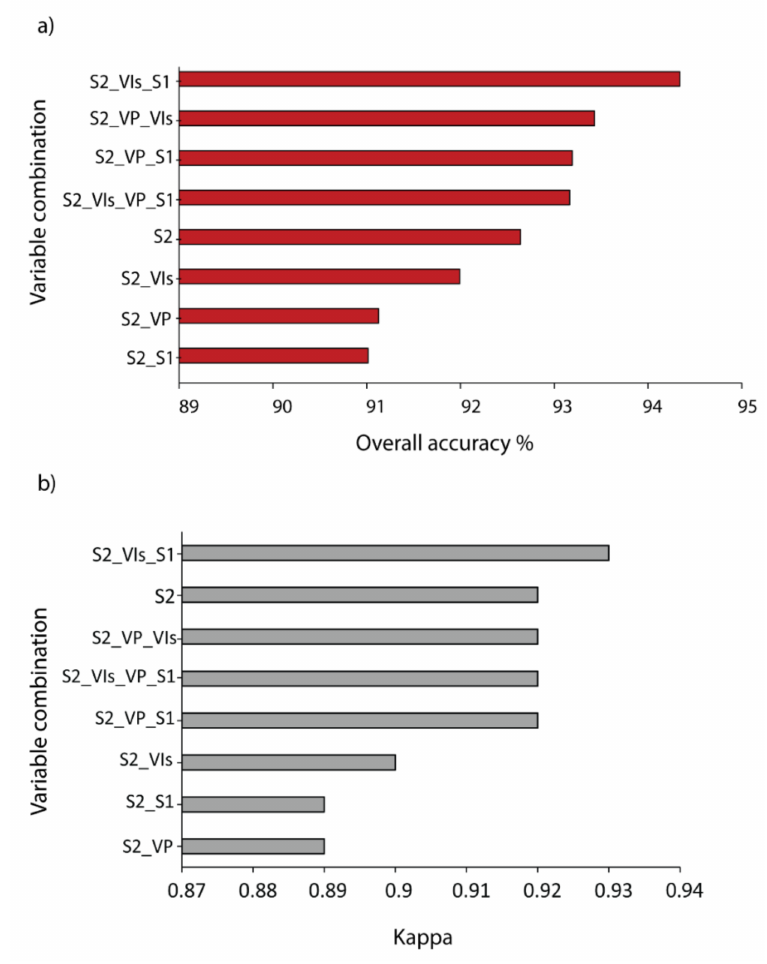
Figure 5. Summary of the ( a ) overall accuracy and ( b ) Kappa of cropping pattern and non-cropland classification using Figure 3 reflectance bands (S2 bands), vegetation indices (VIs), vegetation phenol- ogy (VP), and Sentinel-1 (S1) backscatter data. Table 8. McNemar’s test for comparing the performance of cropping patterns classification using guided regularized random forest-selected variables of scenarios C1–C8. C1 = Sentinel-2 reflectance bands (S2 bands); C2 = S2 bands and vegetation indices (VIs), i.e., S2 bands and VIs; C3 = S2 bands and vegetation phenology (VP), i.e., S2 bands and VP; C4 = S2 bands and Sentinel-1 (S1) backscatter data, i.e., S2 bands and S1; C5 = S2 bands, VIs, and S1; C6 = S2 bands, VP, and S1; C7 = S2 bands, VIs, and VP; and C8 = S2 bands, VIs, VP, and S1 used for mapping the studied cropping patterns. The level of significance ( p -value) is set at ≤